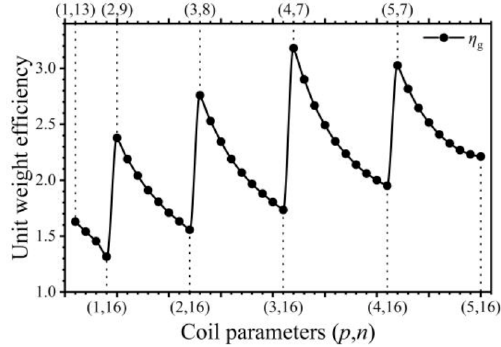
Figure 12. Unit weight efficiency with different coil parameters.